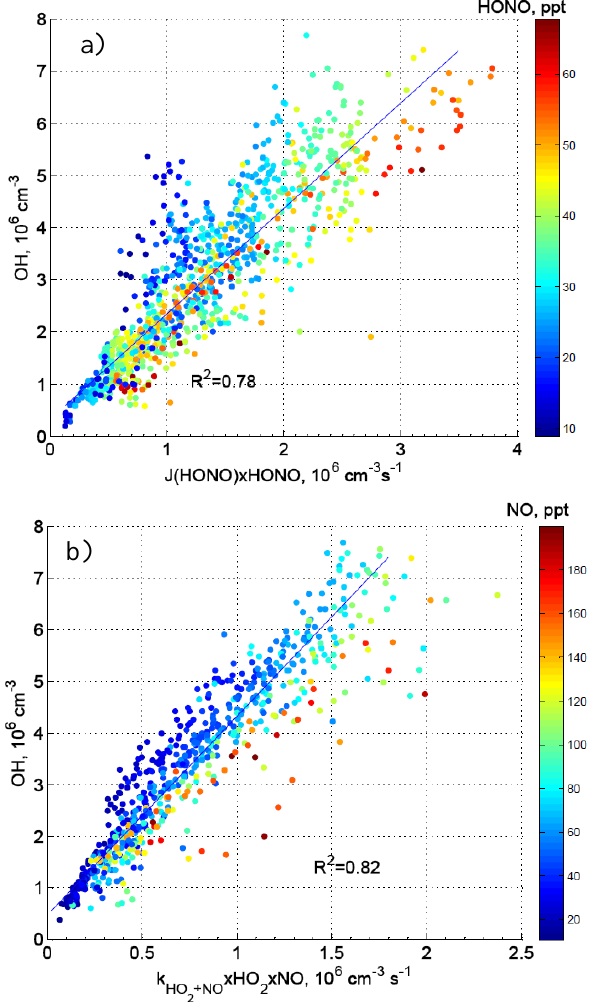
Figure 7. Modelled with the 0-D model vs. measured [OH] (a) and [RO 2 ] (b) : yellow – with PSS estimated HONO; blue – with measured [HONO]. Coefficients a , b correspond to intercept and slope, respectively. Black lines correspond to linear dependences with a = 0 and b =